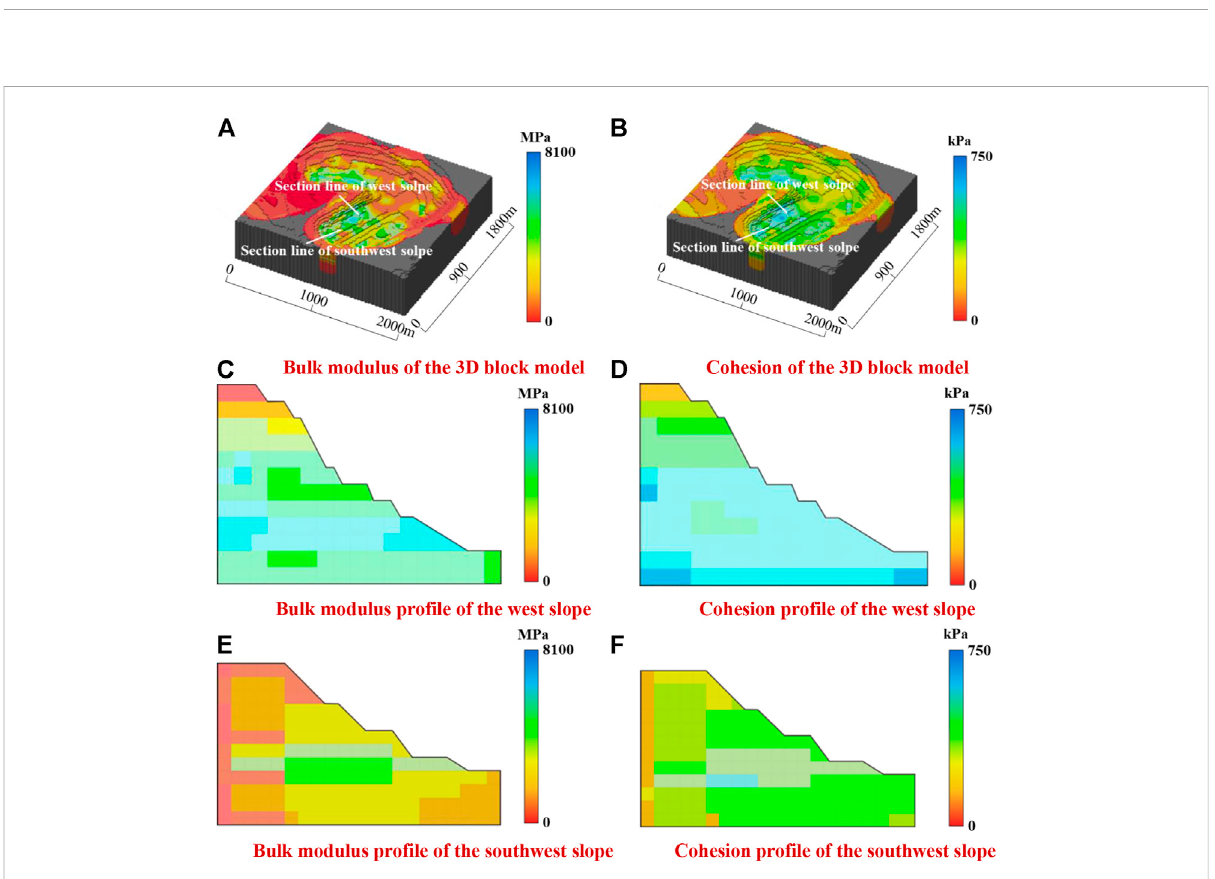
FIGURE 6 3D block model of the rock-mass mechanical parameters. (A) Bulk modulus of the 3D block model; (B) Cohesion of the 3D block model; (C) Bulkmoduluspro fi leofthewestslope; (D) Cohesionpro fi leofthewestslope; (E) Bulkmoduluspro fi leofthesouthwestslope; (F) Cohesionpro fi leof the southwest